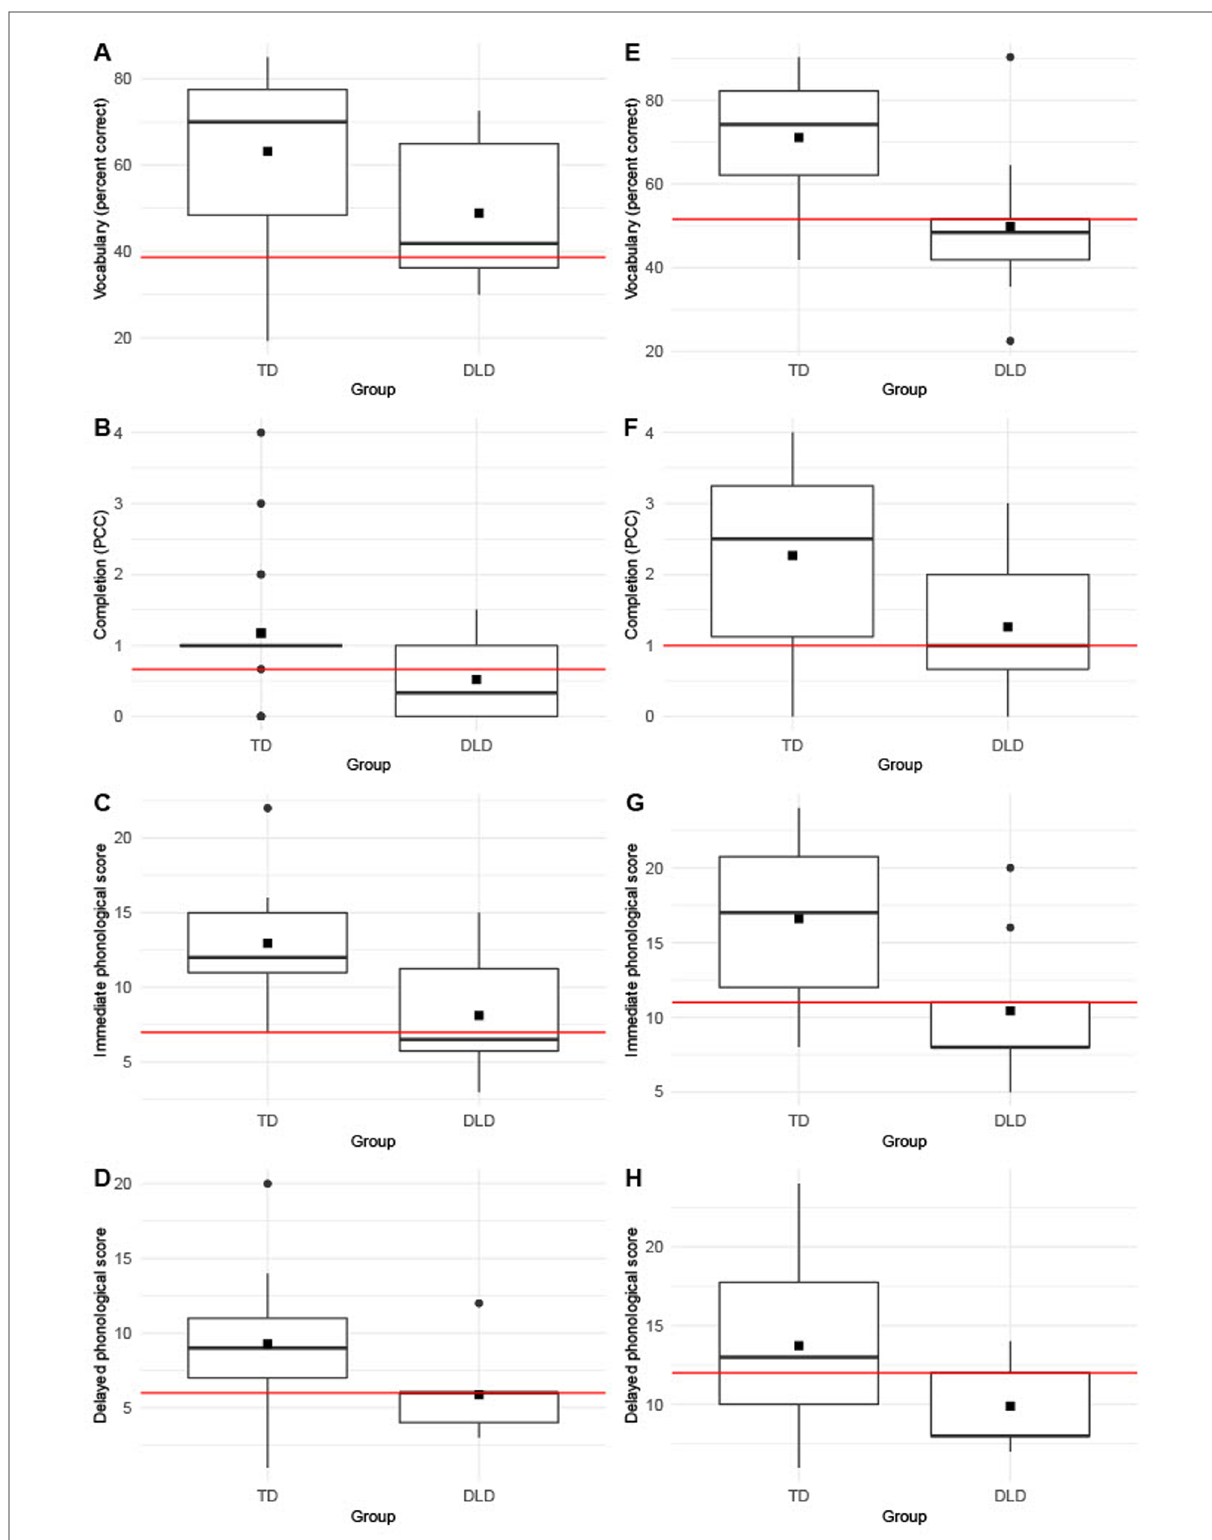
FIGURE 1 Boxplots of the results on each measure according to age group. ( A – D ): Results for the group of children between 4 and 6 years; ( E – H ): Results for the group of children between 7 and 8 years; Red line represents the optimal cut-off. The square represents the